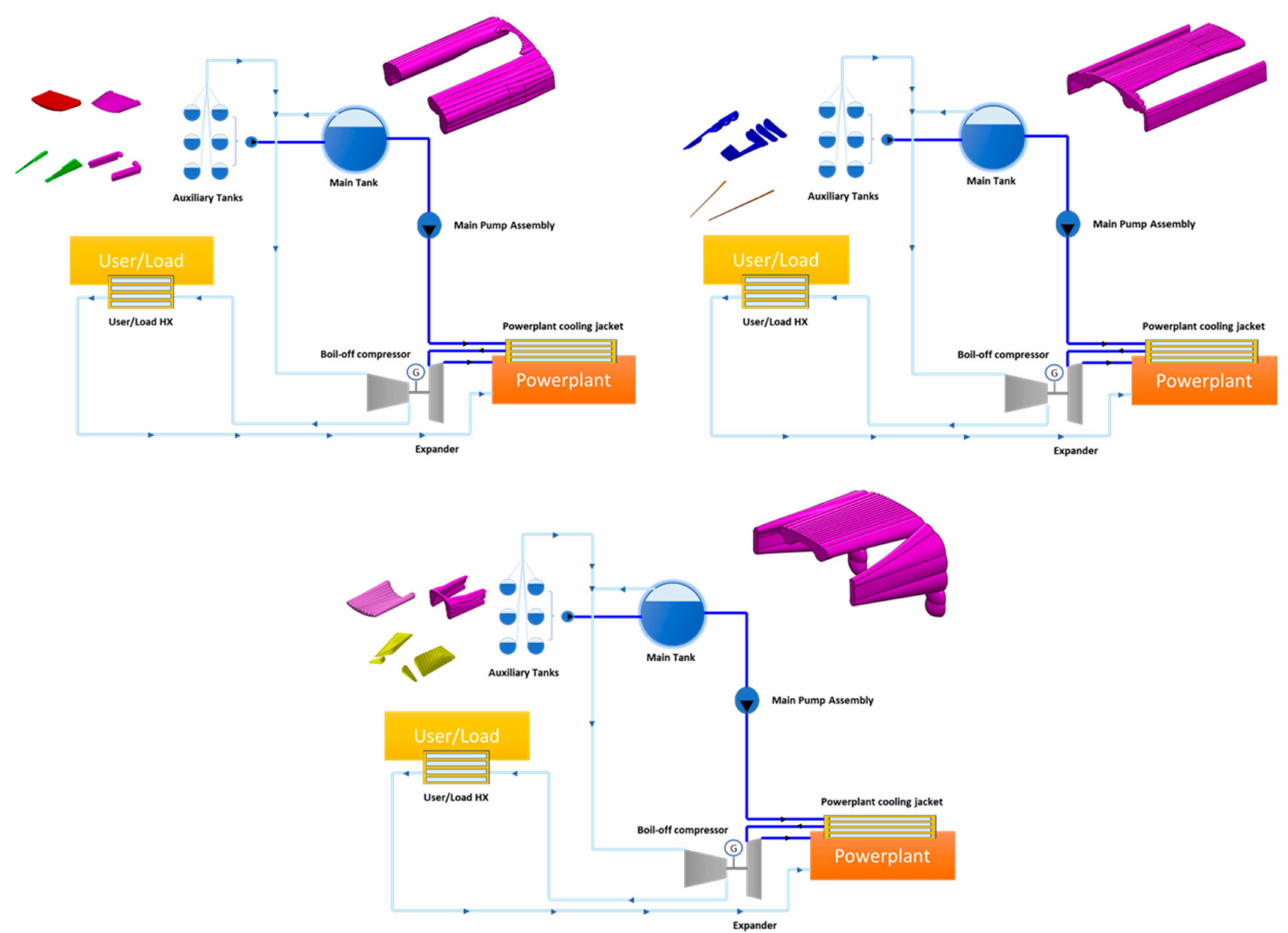
Figure 7. Thermal management system